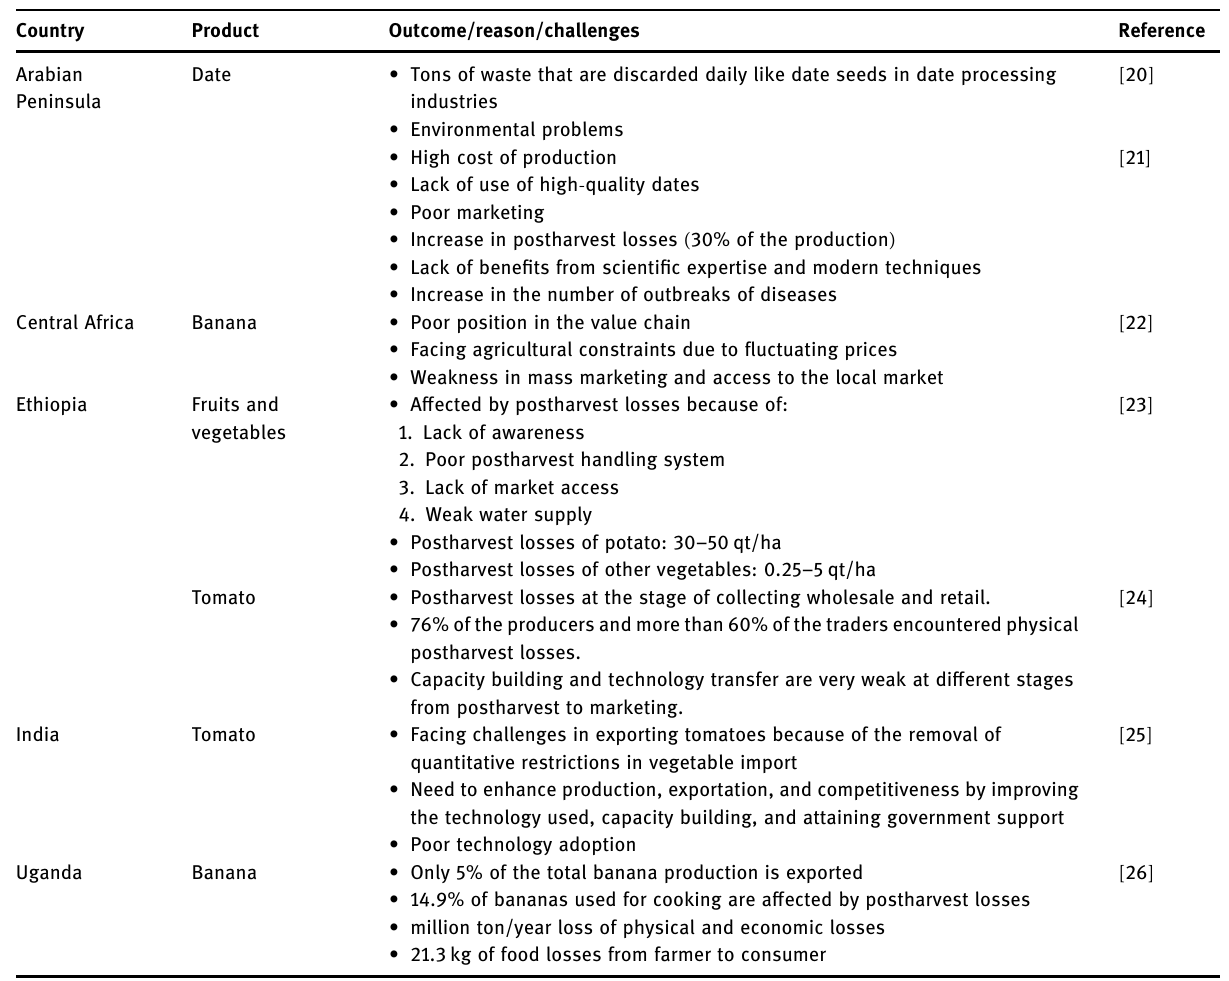
Table 2: Postharvest food losses ( without using value addition )